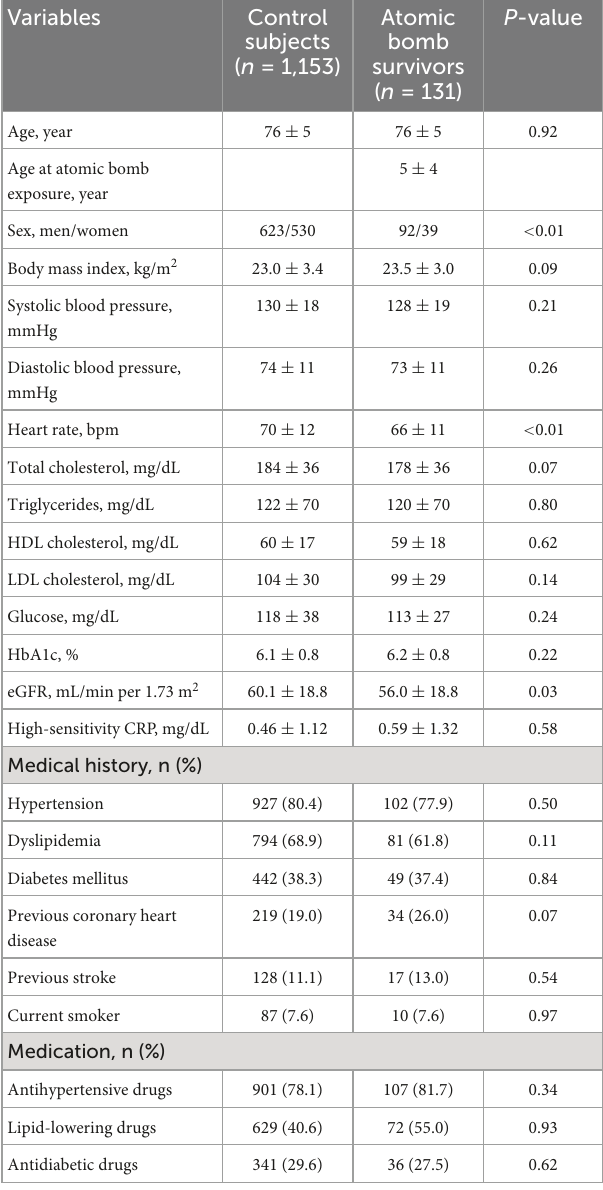
TABLE 1 Clinical characteristics of the subjects corresponding to study protocol 1. Variables Control subjects ( n =